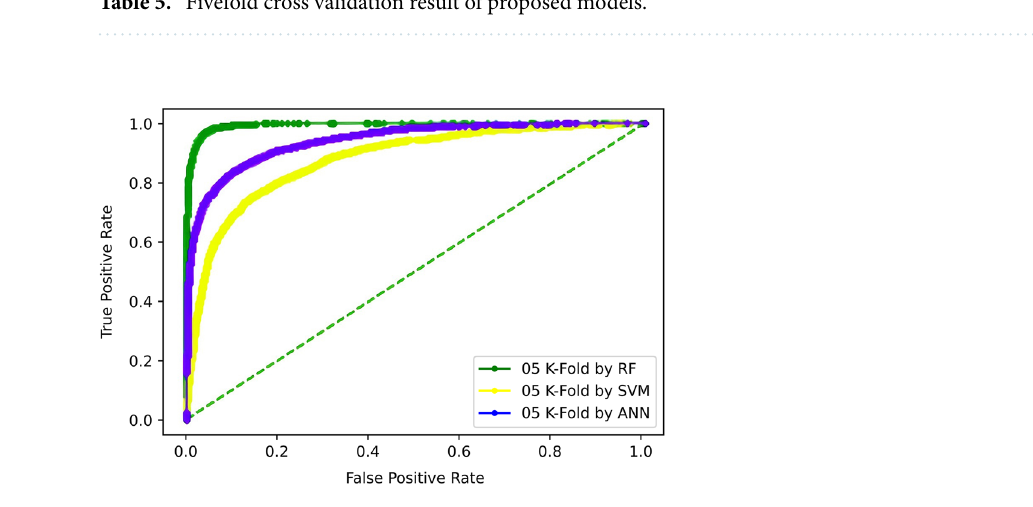
Figure 9. Fivefold cross-validation comparison of ROC.